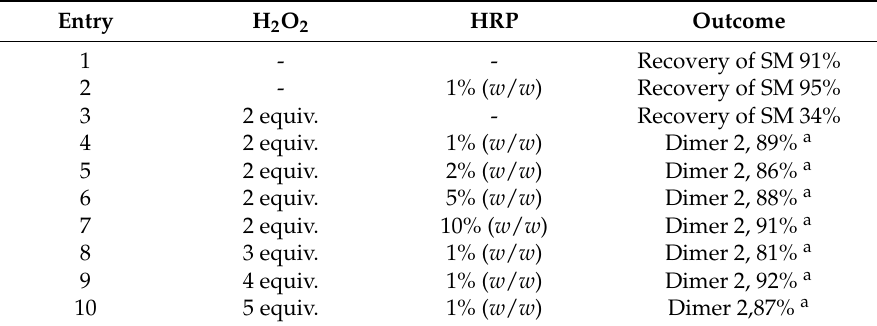
Table 1. Testing of HRP-catalysed oxidation of 5-methylpyrogallol 1